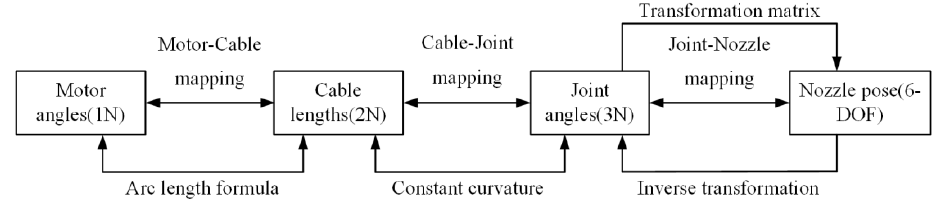
Figure 5. Multilevel mapping relationship of CDFM.